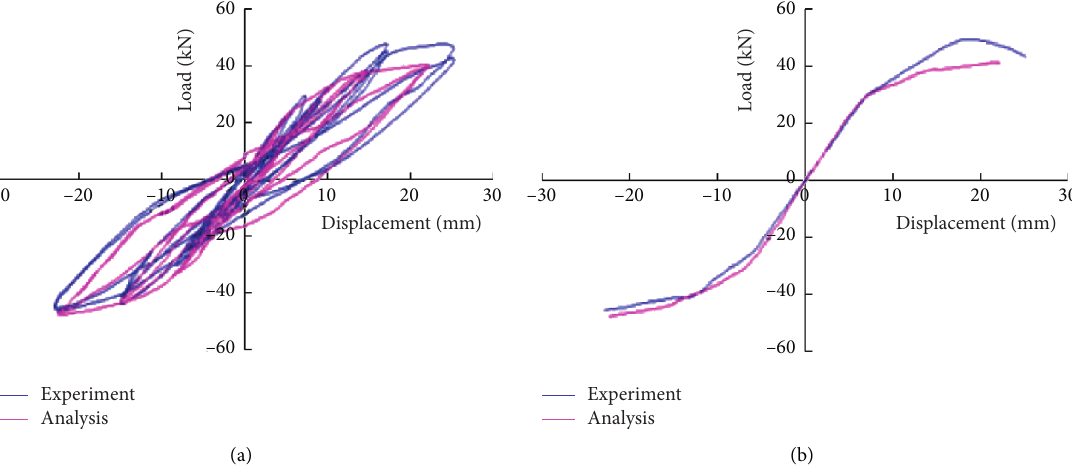
Figure 10: Comparison of the hysteretic curves and skeleton curve of model 2 (before): (a) hysteretic reinforcement; (b) skeleton